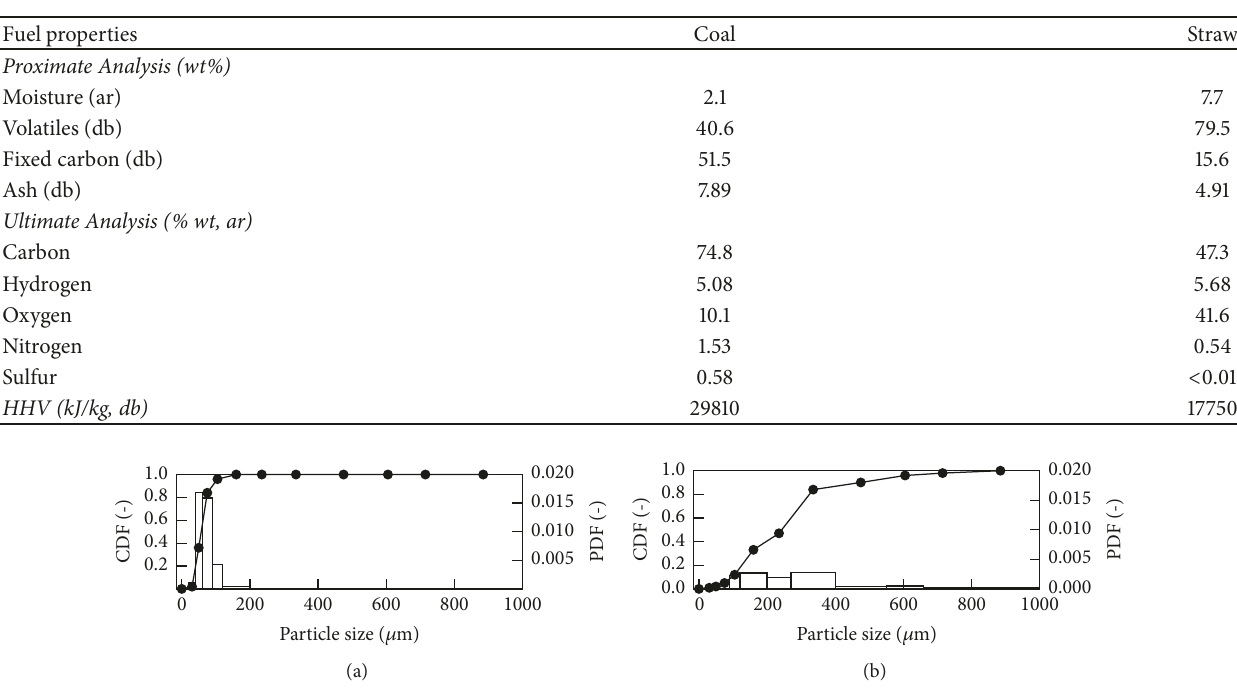
Table 2: Properties of coal and straw [5].